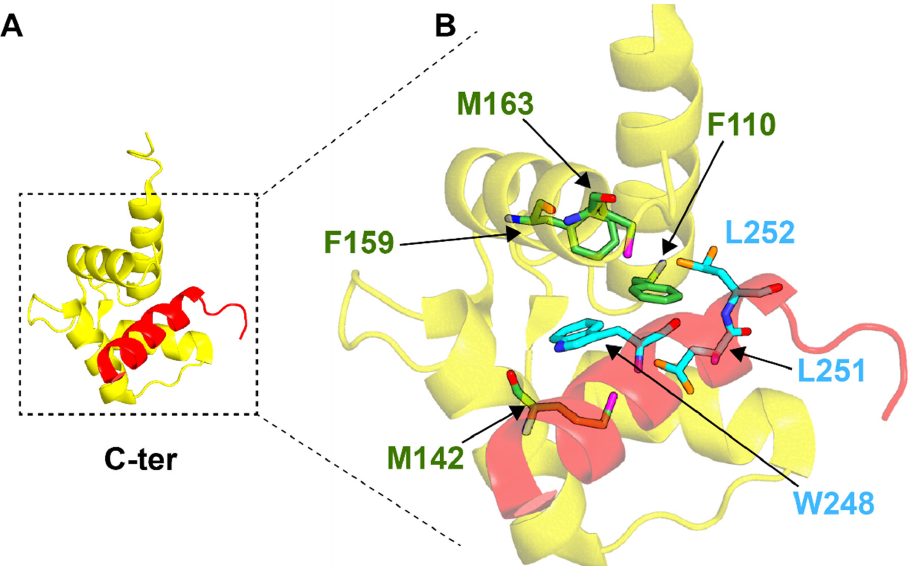
Figure 4. NMR structure of the complex between the C-terminal domain of CrCEN and the KAR1 peptide (PDB: 1OQP). ( A ) The centrin molecule is represented in yellow and the KAR1 peptide is shown in red. ( B ) Magnification of the binding site of CrCEN. Key residues, defining the interface of interaction, are reported as green (CrCEN) and cyan (KAR1 peptide) residues.